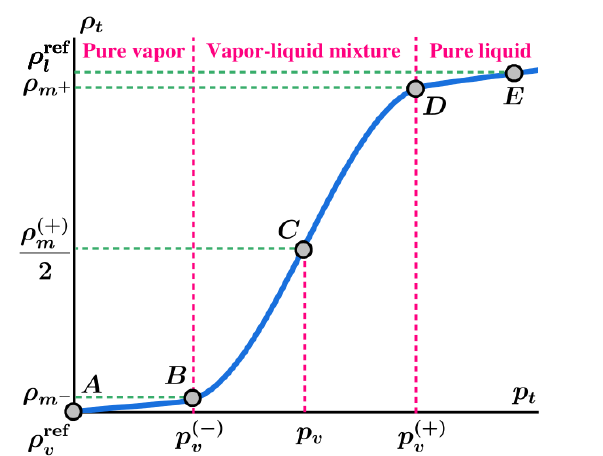
Figure 4. EOS for the cavitation model used in the SPH model [73]. The blue line denotes the curve of pressure and density, the pink and green lines represent auxiliary reference lines for pressure and density, AB denotes the pure vapor region, BD denotes the mixture region, DE denotes the pure liquid region, and C is the